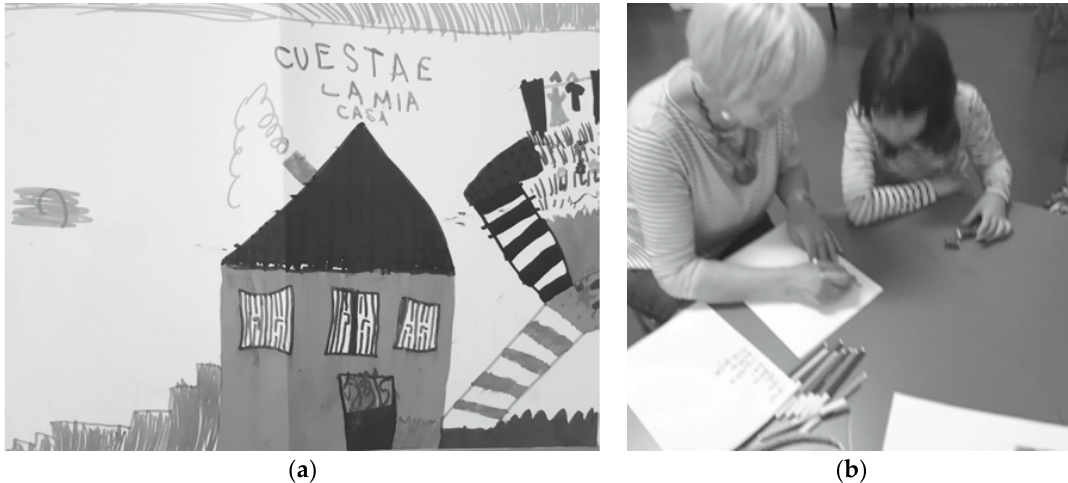
Figure 1 . The first evaluation consisting in the graphical trace. ( a ) The drawing by J., ( b ) B. watches the experimenter drawing while she verbalizes.